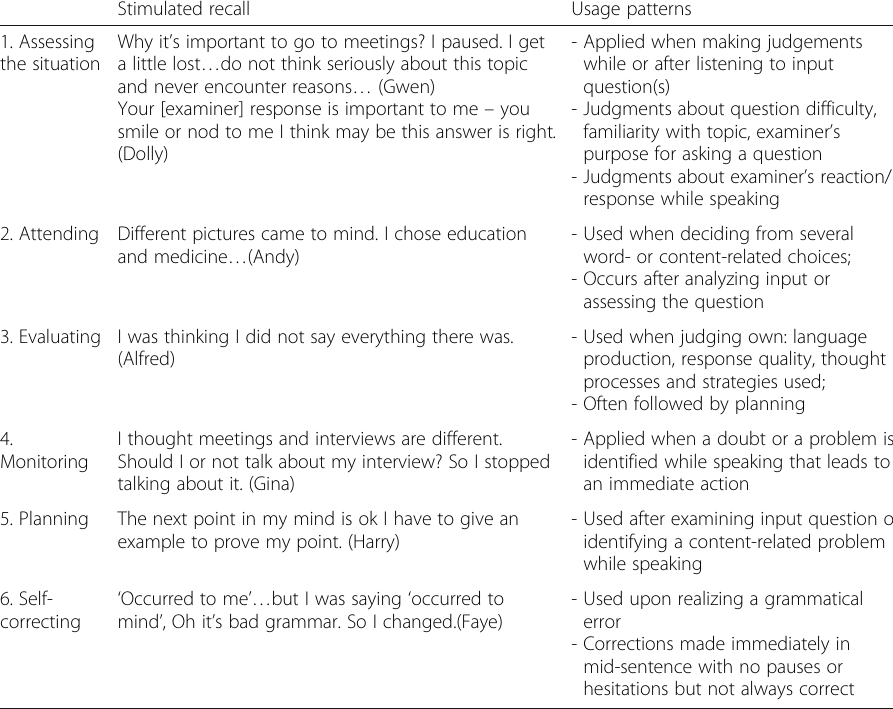
Table 4 Individual metacognitive strategies used and usage